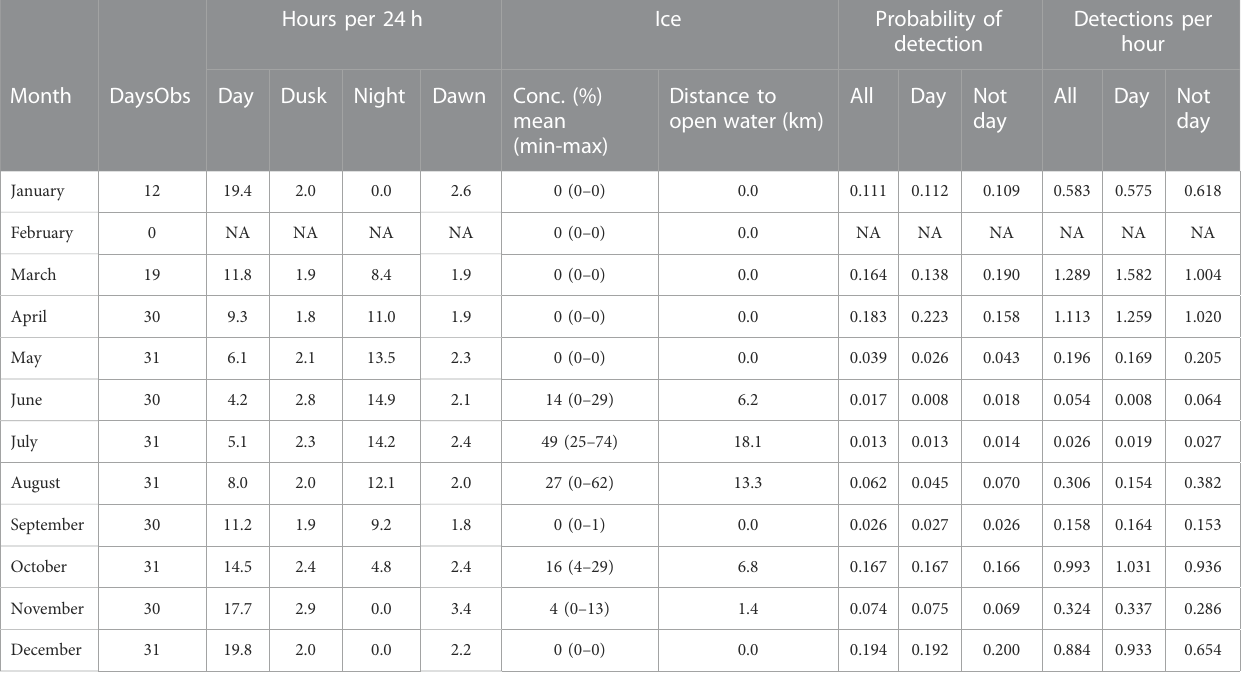
TABLE 4 A3 summary information by month. Other information as caption Table